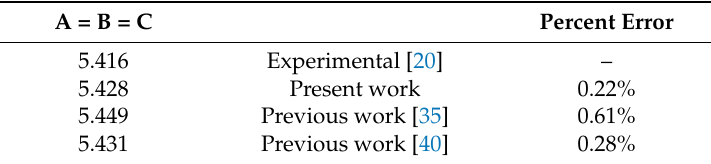
Figure 2. Optimized pyrite unit cell. Table 1. Optimized lattice parameters (in Å) of bulk pyrite (1 0 0).